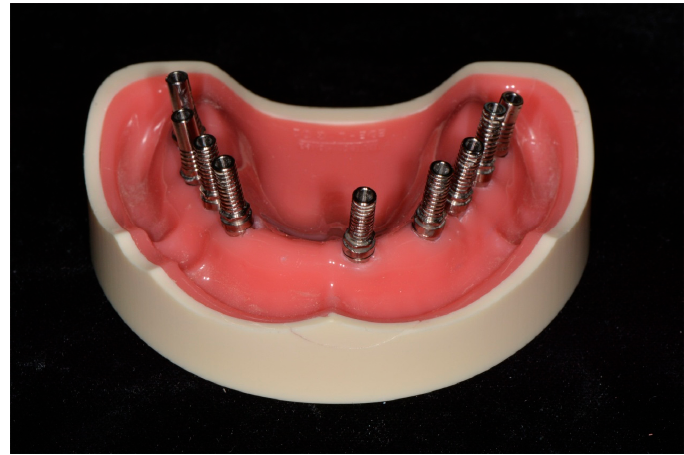
Figure 7. Cylinders connected to the multiple abutments of the implant.